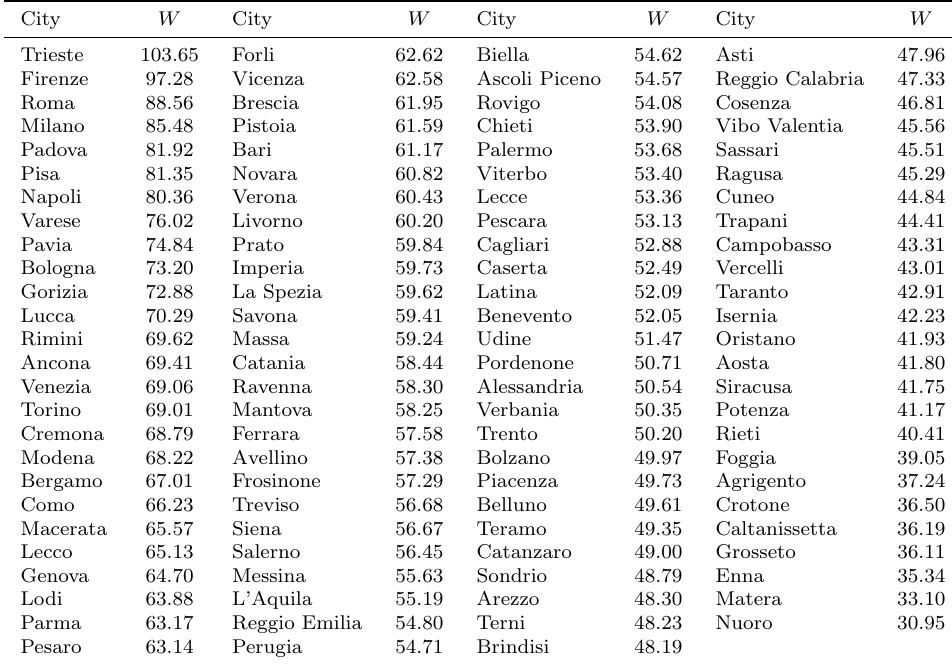
Table 3: City ranking according to W values